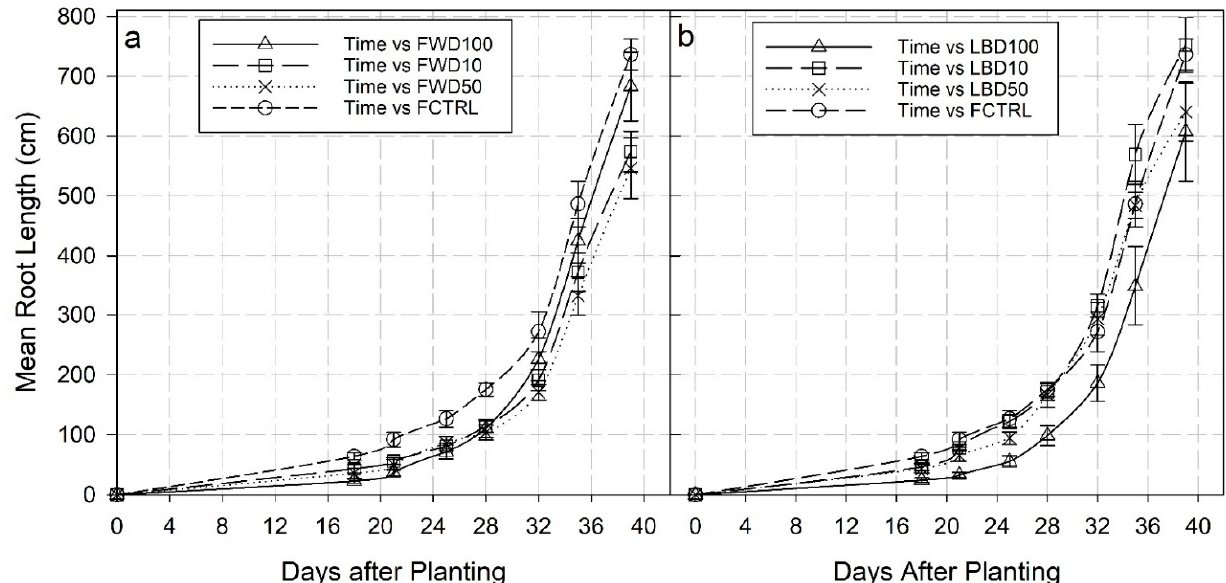
Figure 3. Mean root growth dynamics of kai choy plants during the 40-day greenhouse experiment, as affected by FWD ( a ) and LBD ( b ). Error bars represent the standard error of the mean ( n = 5).